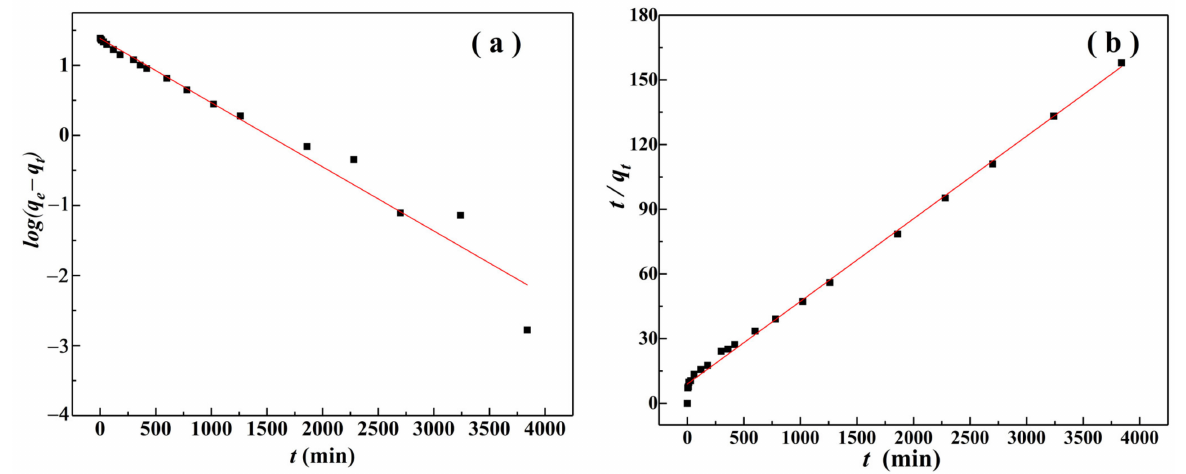
Figure 10. Pseudo-first-order kinetic plot ( a ) and pseudo-second-order kinetic ( b ) plot for Cr (VI) adsorption on α –FeO(OH)/GOCS at 298.15 K.